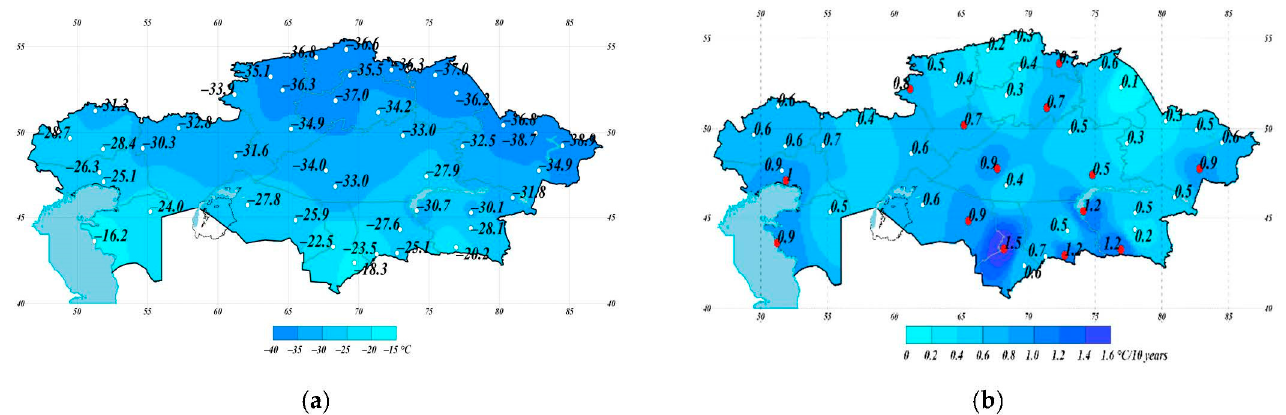
Figure 6. Spatial distribution of the index characterizing minimum monthly values of minimum daily air temperatures (TNn) ( a ) and trends ( b ) of this parameter for the period 1971–2020. The largest monthly values of the minimum daily air temperatures (TNn) are observed in the south and southwest, which confirms our assumption of conditional division into two equal parts along the diagonal line from northwest to southeast.